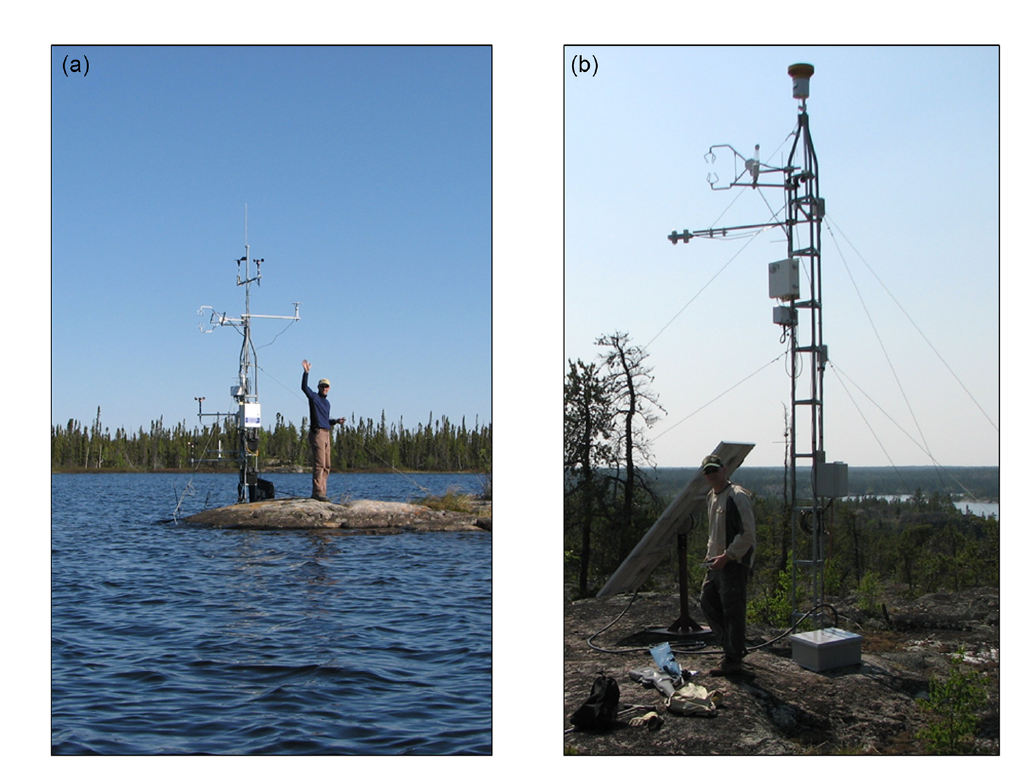
Figure 4. Photos of (a) the climate tower at Landing Lake and (b) the climate tower on the bedrock ridge above Vital